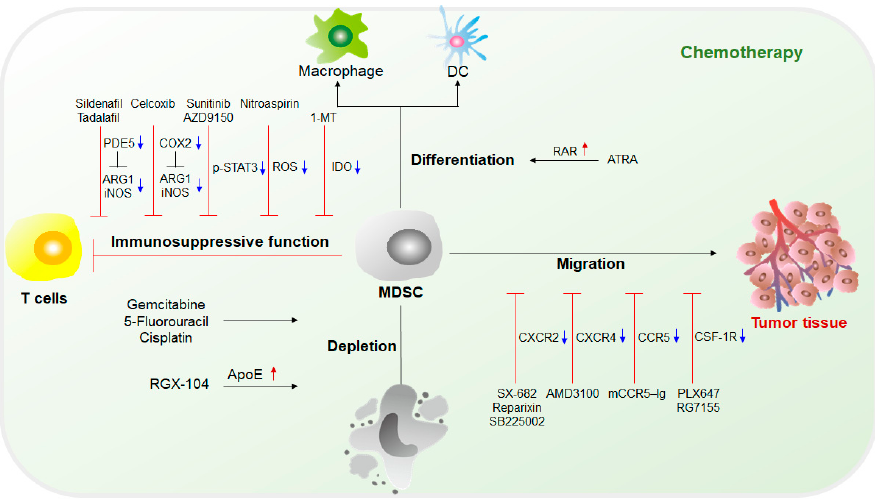
Figure 3. Chemotherapy targeting MDSCs. Current chemotherapeutics targeting MDSCs are mainly